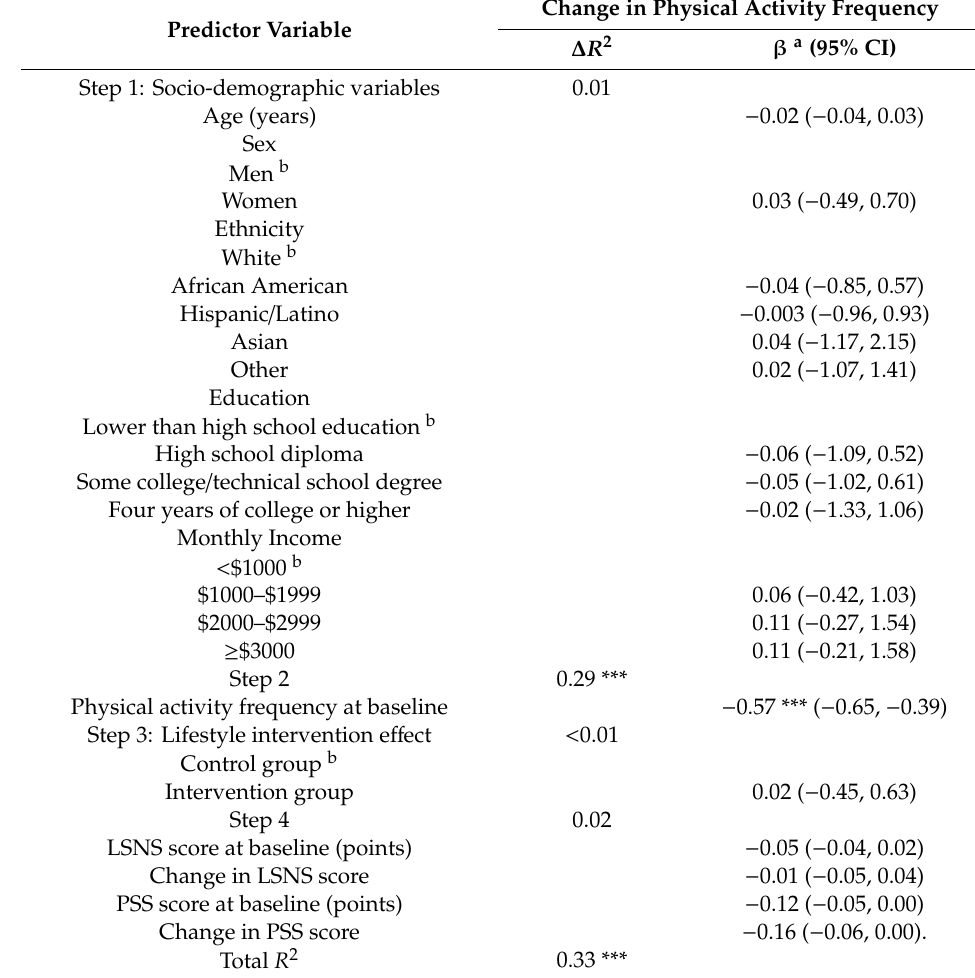
Table 4. Hierarchical multiple regression analyses examining the association of the lifestyle intervention e ff ect with change in physical activity frequency ( n =